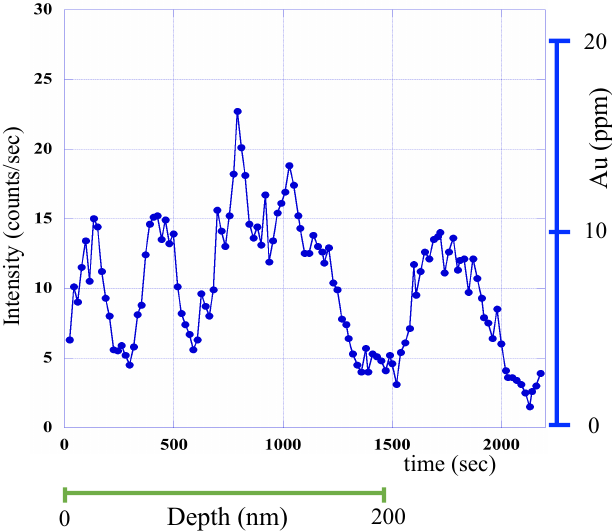
Figure 5. Secondary ion mass spectrometry (SIMS) depth profile of Au in pyrrhotite (Au1*14.adp in Table A1) from the Kalahari Goldridge deposit. The analysis started at the surface of the pyrrhotite grain (left end of the graph) and proceeded toward the interior (right end of the graph), resulting in the formation of a crater. The left vertical axis shows the raw data in counts per second. The right vertical axis shows the Au concentration (ppm) in pyrite calculated from the raw data using the RSF Au-pyrrhotite value. Note that the crater is very shallow and several peaks of Au with of approximately 50 nm in width (Au nanoparticles (NPs)) were observed. RSF: relative sensitivity